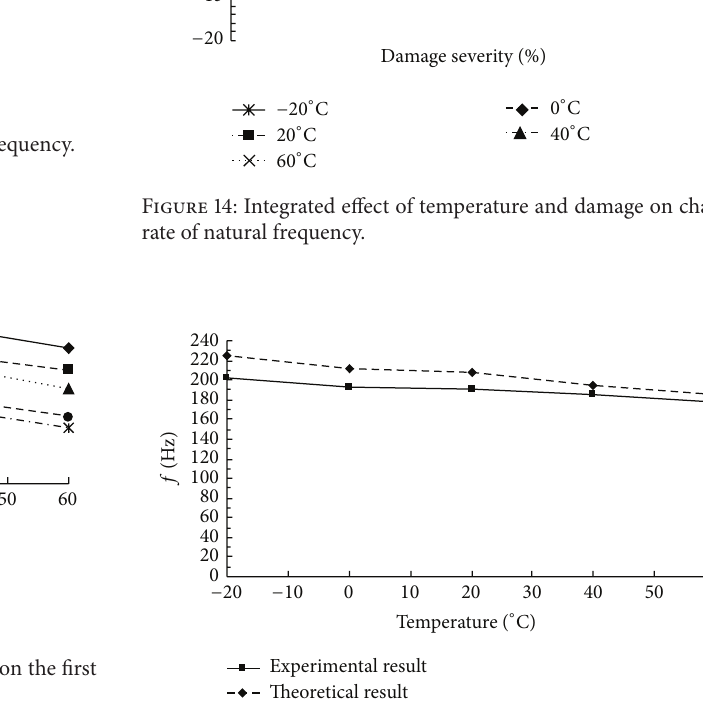
Figure 15: Relationship between theoretical and measured fre- quency of concrete